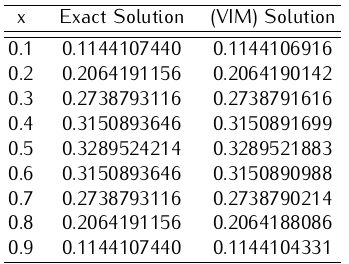
Table 2. (VIM) applied to Bratu’s problem for the case λ